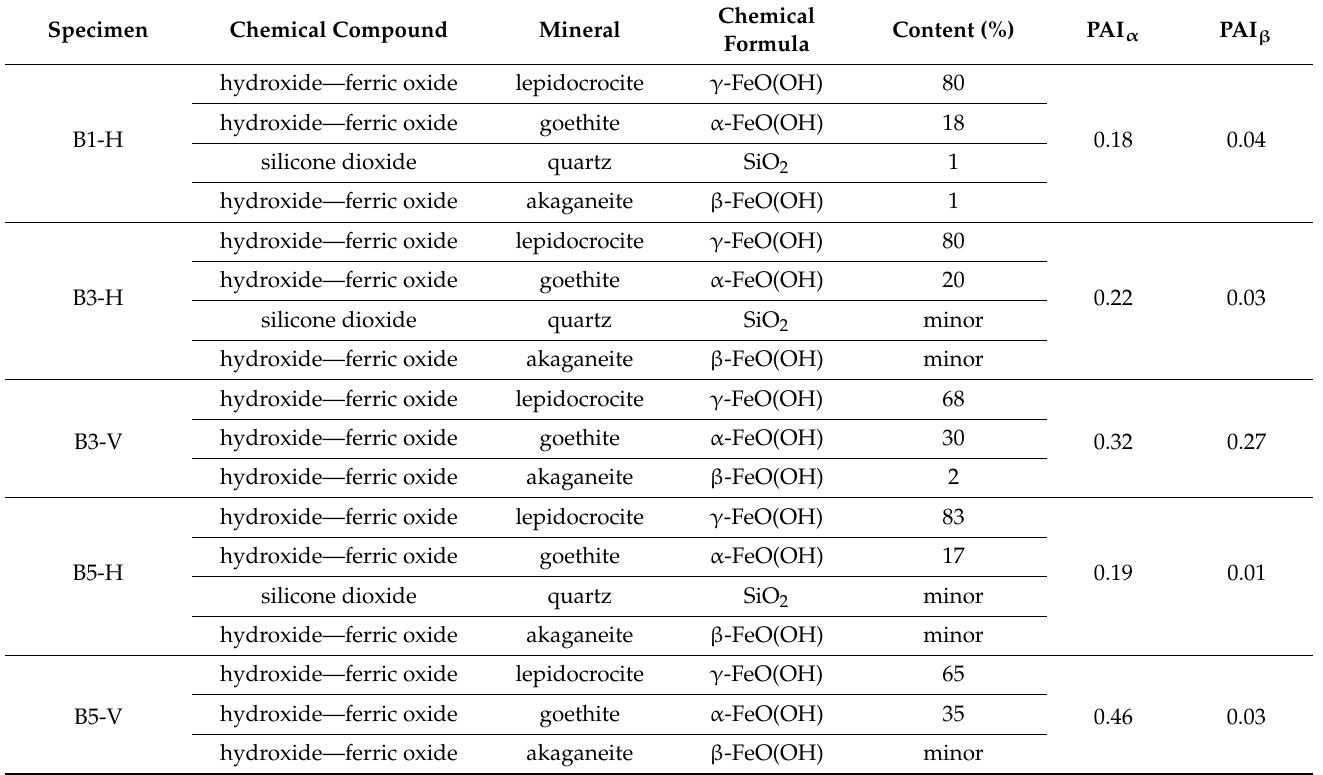
Table 31. X-ray diffraction